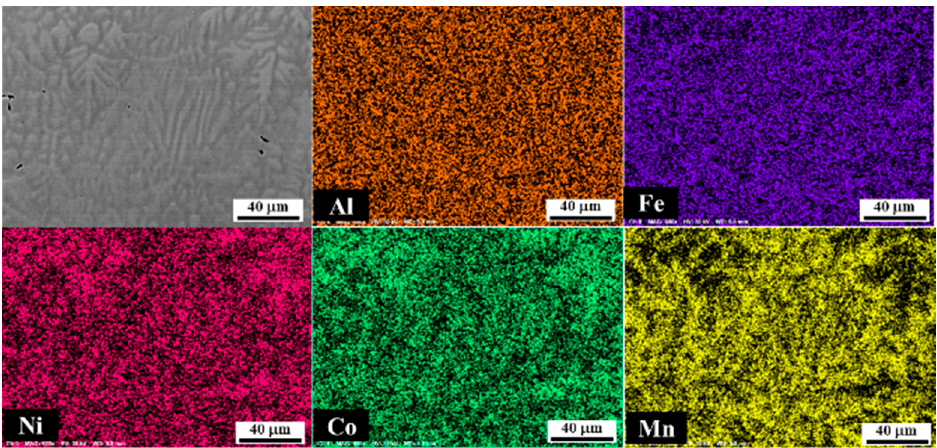
Figure 4. Typical microstructure and elemental mapping of the as-cast Al(CoFeMnNi) quinary alloy exhibiting dendritic microstructure.